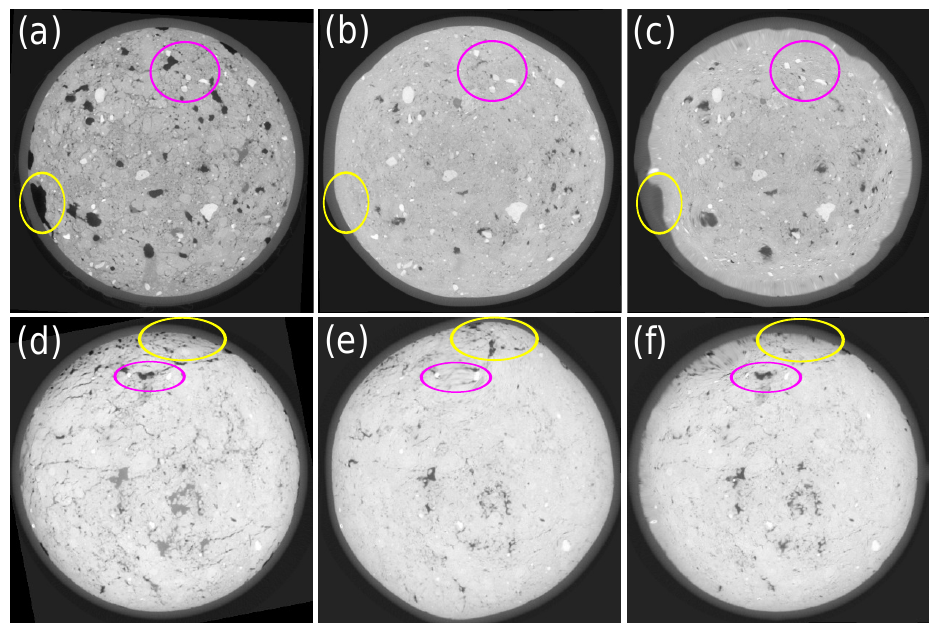
Figure 7. Representative slice of the Köllme soil close to saturation (a) . The B-spline transformation matrix of the rock matrix in the Köllme soil at ψ = − 500kPa is applied to the corresponding grayscale image (b) . B-spline transform of the original Köllme soil at ψ = − 500kPa (c) . Same comparison for the Bad Lauchstädt soil close to saturation (d) and at ψ = − 500kPa (e, f) . Pink and yellow frame highlight salient